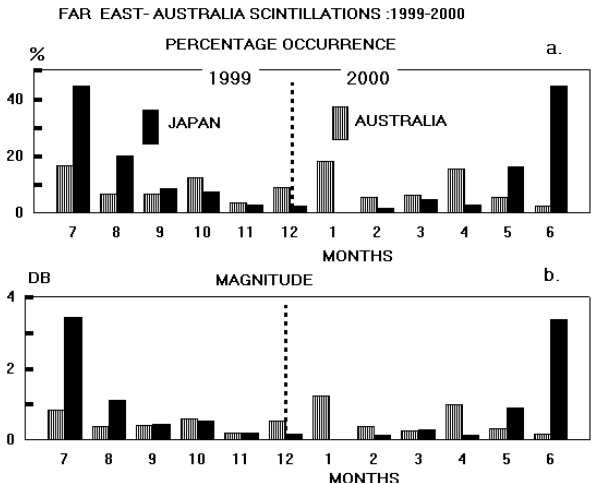
Fig. 5. Comparative mid-latitude scintillation occurrences (percent- age occurrence and magnitude) in the Far East and Australia during one-year simultaneous recording.